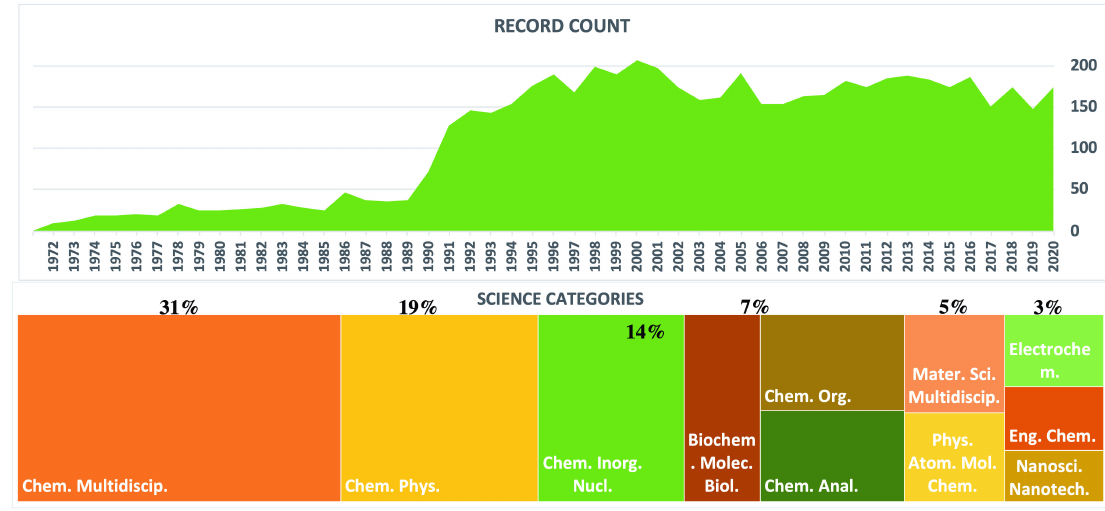
Figure 2. Results of the search in the Web of Science using metalloporphyrin as keyword in “all fields” (September 2021) presented as record count since 1972 and distribution by science categories (considering only the ones with more than 150 records).